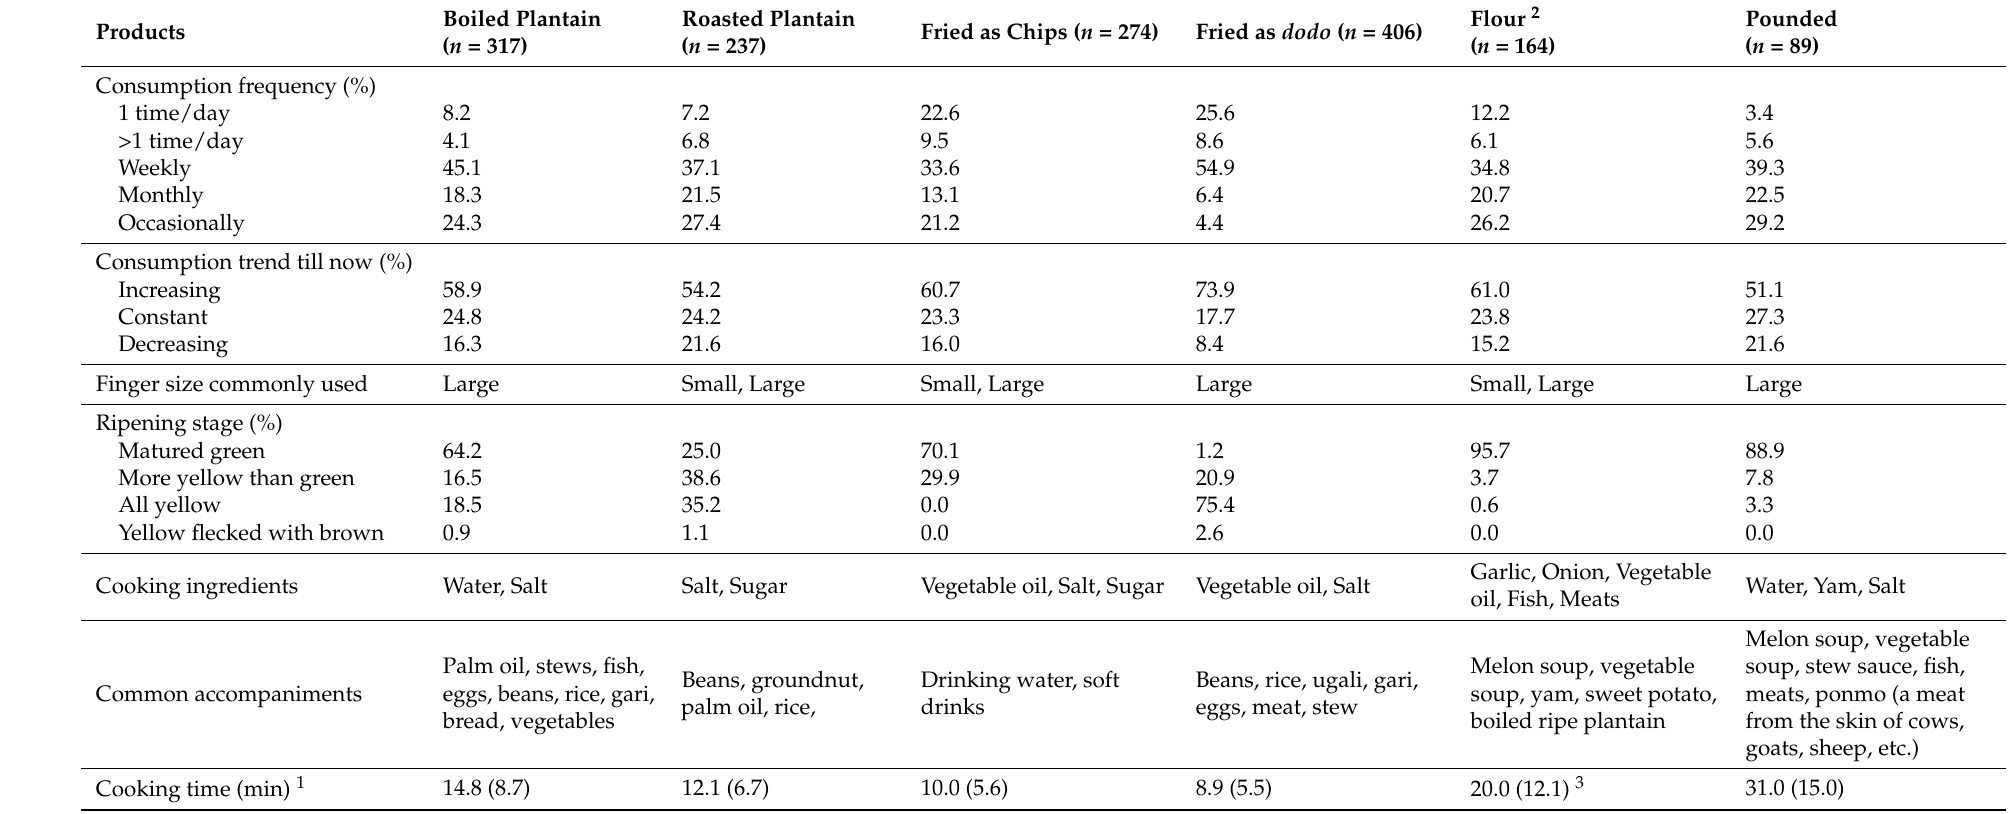
Table 3. Consumption characteristics and cooking methods of plantain-based products in